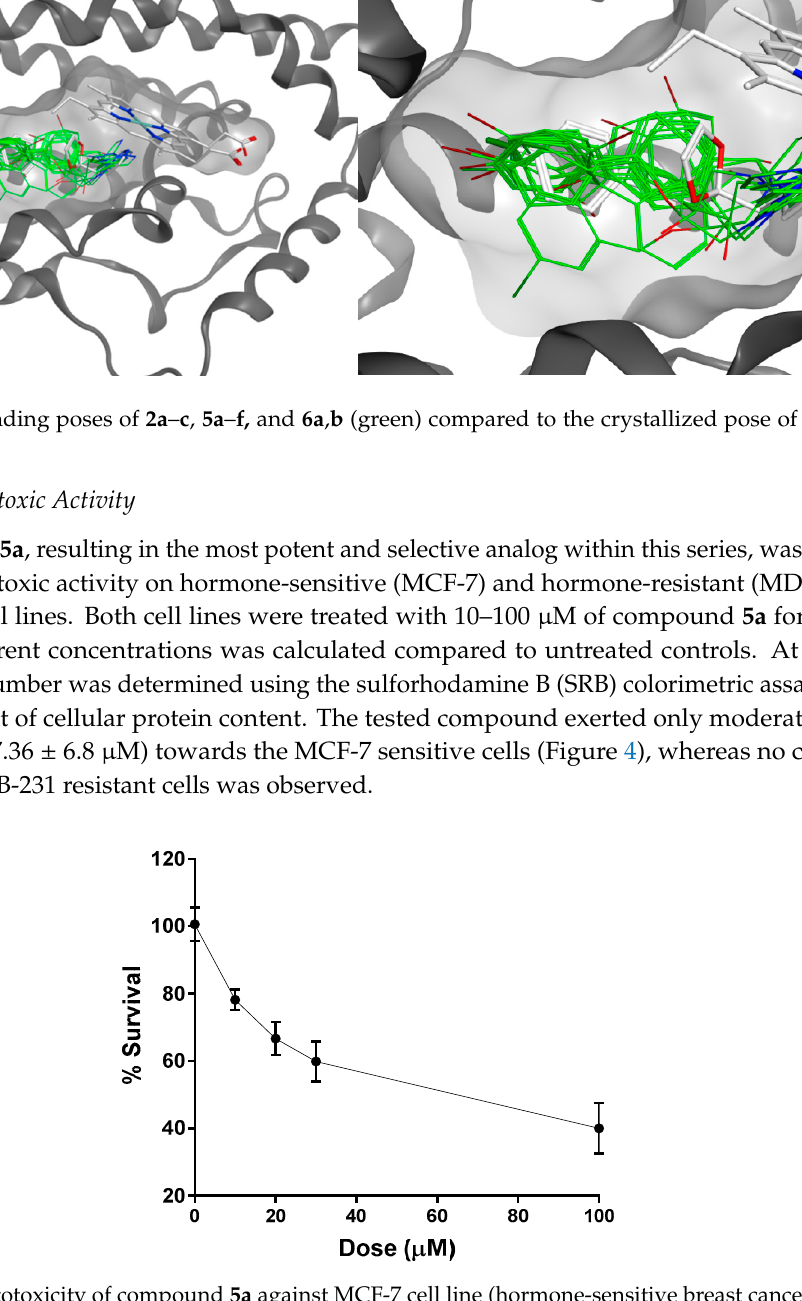
Table 2. Docking results for the studied molecules 2a – c , 5a – f, and 6a , b .